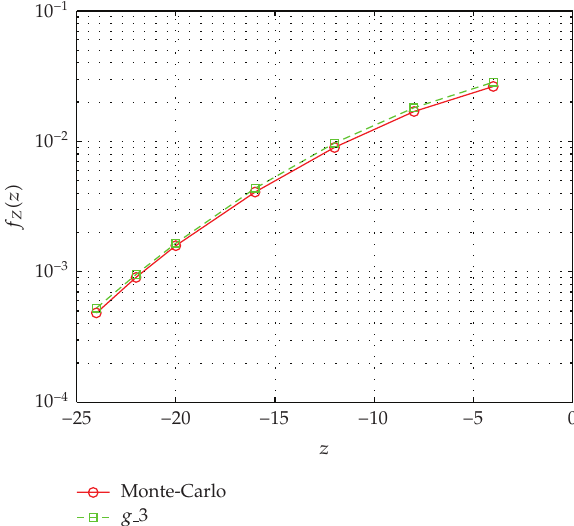
Figure 3: Left tail f Z ,ρ > σ 1 /σ 2 . g 3 is the approximation.